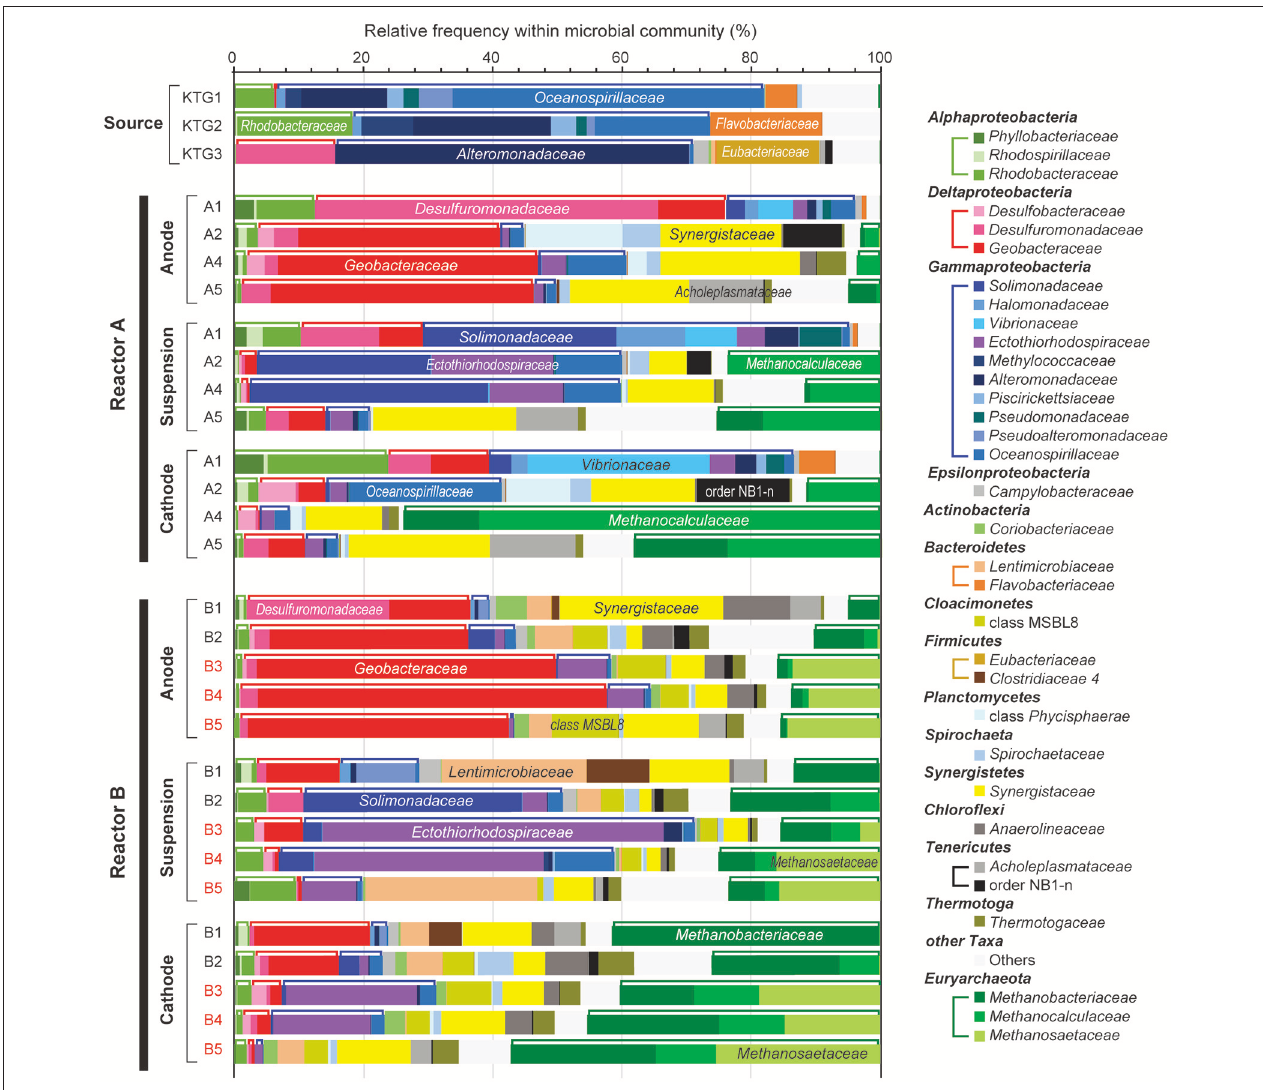
FIGURE 4 | Taxonomic distributions of 16S rRNA community profile within anode biofilm, suspension, and cathode biofilm of electromethanogenic BESs. The family-level taxonomic profiles (three unclassified families are shown by using upper level taxonomy) for anode biofilms (Anode), planktonic cell suspensions (suspension) and cathode biofilm (Cathode) within the duplicate BESs at day 56 (1), day 132 (2), day 280 (3), day 310 (4), and day 566 (5) of enrichment, and the original inoculum source of formation water at different natural gas production wells (Source). Several abundant families are also described in the bars. Class Alphaproteobacteria , Deltaproteobacteria , Gammaproteobacteria, and phylum Euryarchaeota are tied by brackets above the